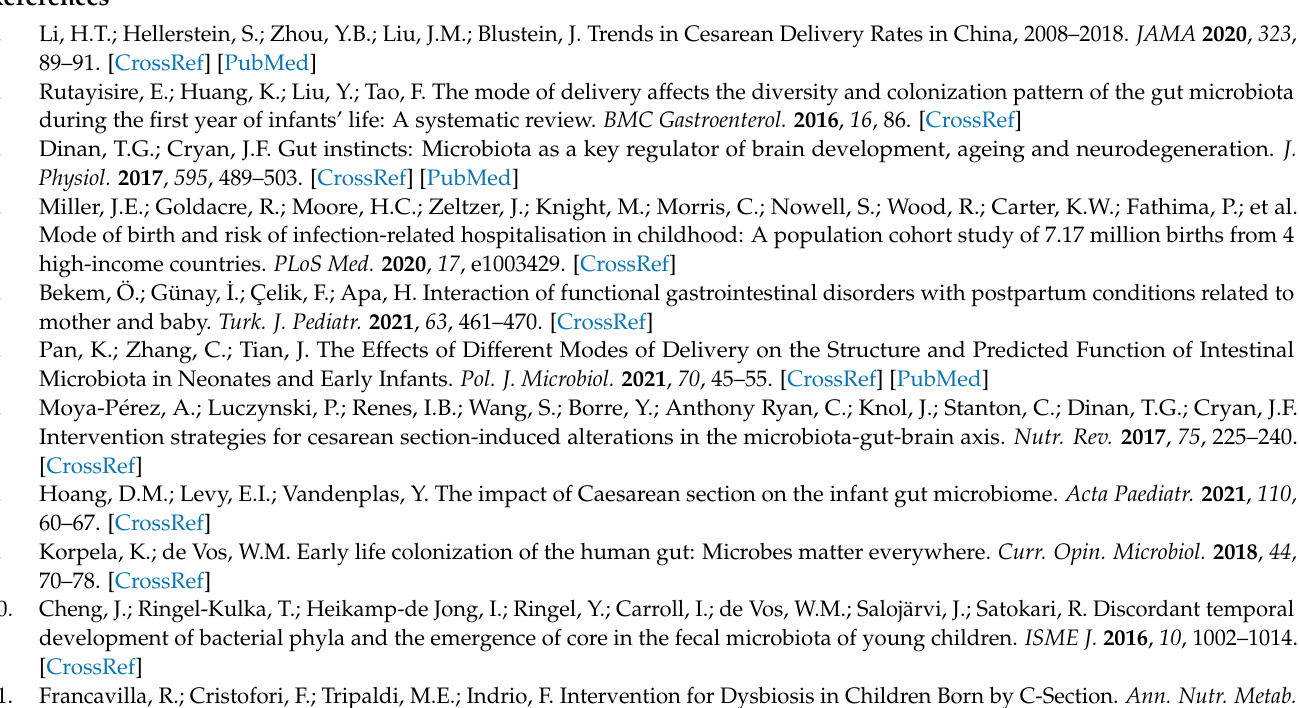
all participants, Table S2: Detection rate of fecal Lactobacillus, Table S3: Correlation between fecal Lactobacillus and biochemical indexes. Figure S1: The changes in relative abundance of species at the phylum level; Figure S2: The changes in relative abundance of species at the genera level; Figure S3: The changes of α diversity indexes by age; Figure S4: PCoA and PLS-DA models for differences in fecal microbiota in all